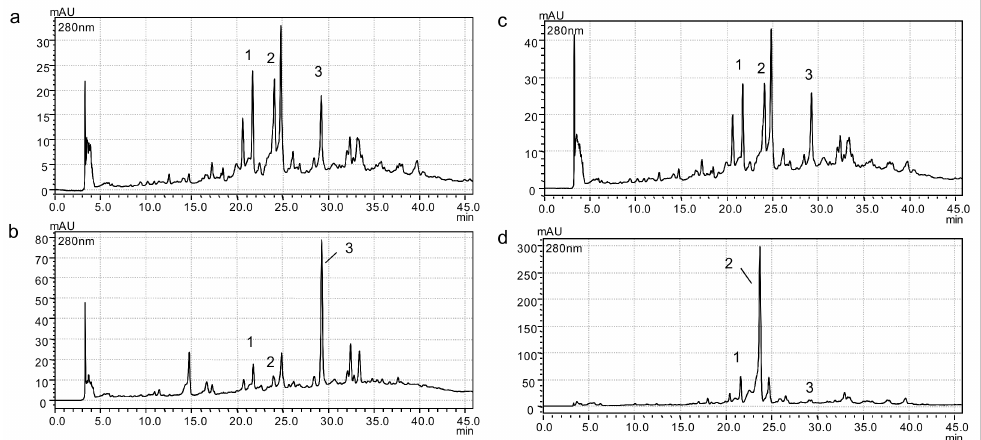
Figure 1. Chromatograms (280 nm) of ethanol extracts obtained by: ( a ) maceration of olive mill leaves (OML) before protein extraction (Scheme 1), ( b ) ultrasound-assisted extraction of OML after protein extraction (Scheme 2), ( c ) ultrasound-assisted extraction of OML before protein extraction (Scheme 3), and ( d ) ultrasound-assisted extraction of olive leaves before protein extraction (Scheme 3). (1) Luteolin 7- O -glucoside, (2) oleuropein, and (3) luteolin.